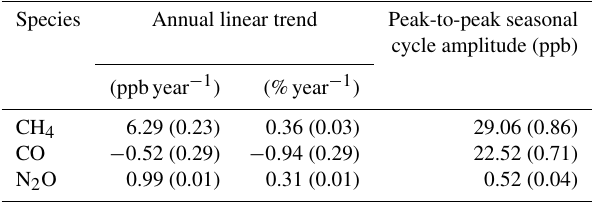
Table 8. Trend analysis results ( N = 737) and bootstrap 1 σ uncer- tainties (bracketed) for the period 2007–2017. The annual trend ex- pressed as a percentage uses the time series mean dry mole fraction (1768.91, 55.16 and 324.29ppb for CH 4 , CO and N 2 O). Species Annual linear trend Peak-to-peak